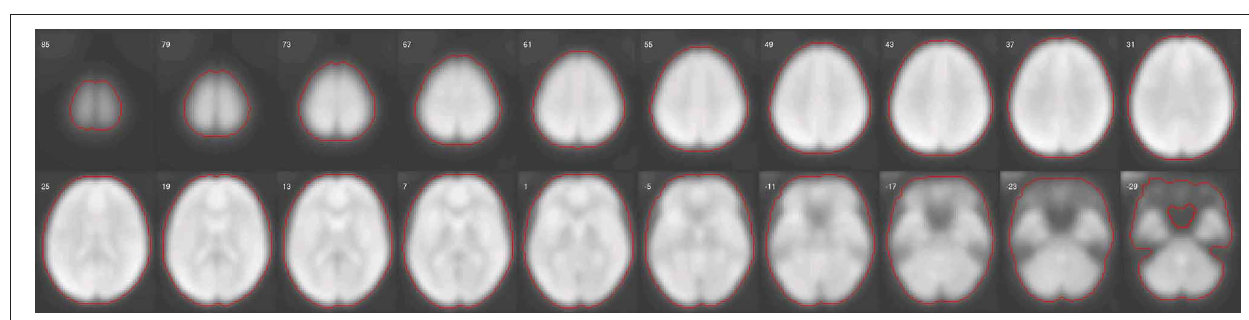
FIGURE A2 | Figure shows slices from the between-subject mean-normalized fMRI volume (see text). Red line indicates the manually-determined edge of the binary mask